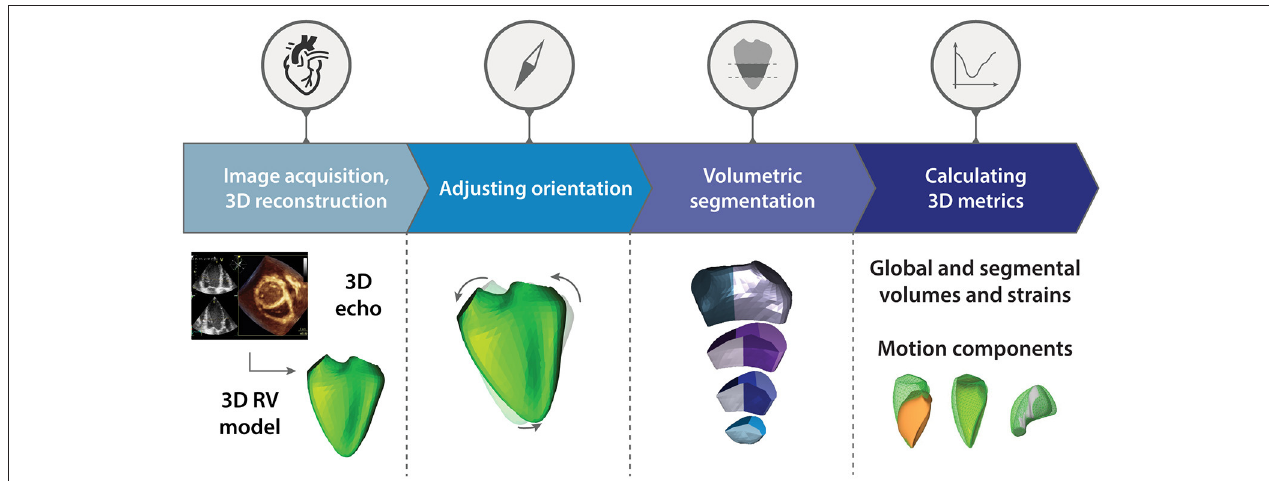
FIGURE 1 | Schematic illustration of the Right VentrIcular Separate wall motIon quantificatiON (ReVISION) analysis pipeline. The updated ReVISION analysis pipeline comprises four consecutive steps: (i) image acquisition and 3D right ventricular model reconstruction, (ii) adjusting orientation, (iii) volumetric segmentation, and (iv) calculation of global and segmental 3D metrics. See text for further details. RV, right